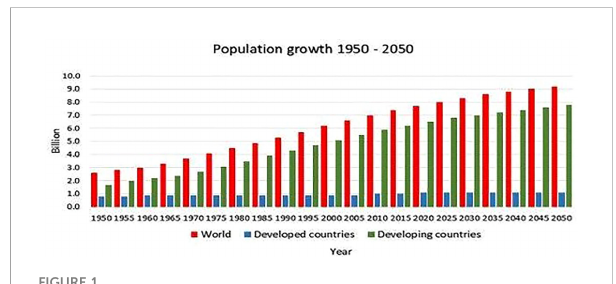
FIGURE 1 Population difference between developed and developing